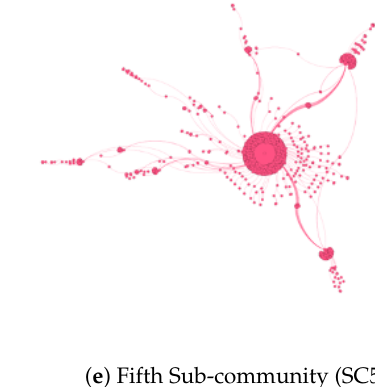
Figure 2. Network Topology for the Five Largest